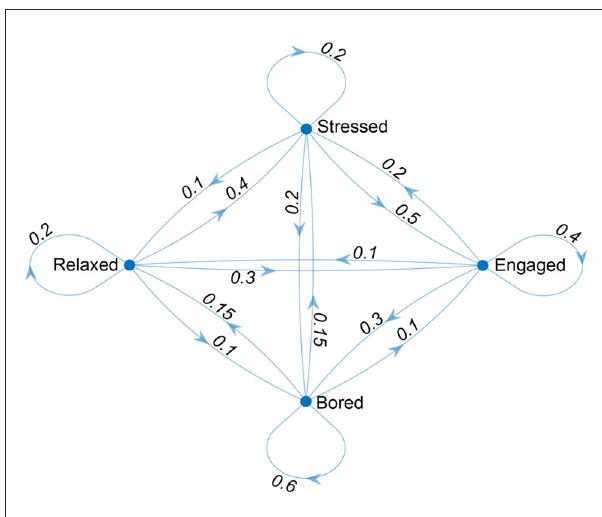
FIGURE1 Affect states’ changes over time (numbers represent probabilities in the Markov chain).